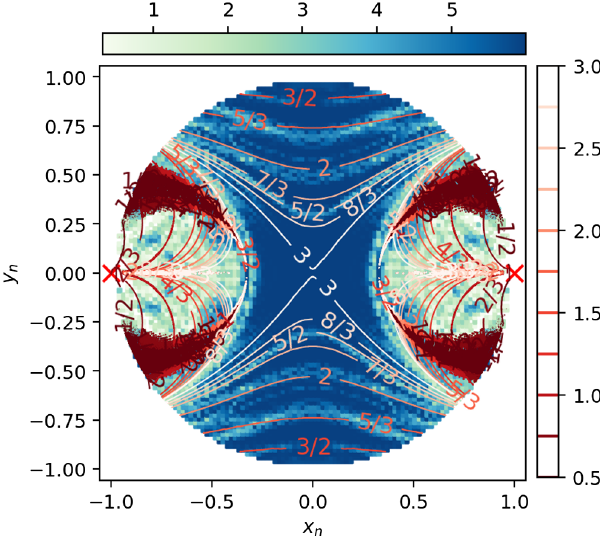
= ν overlaid on top of an y x = ν y x